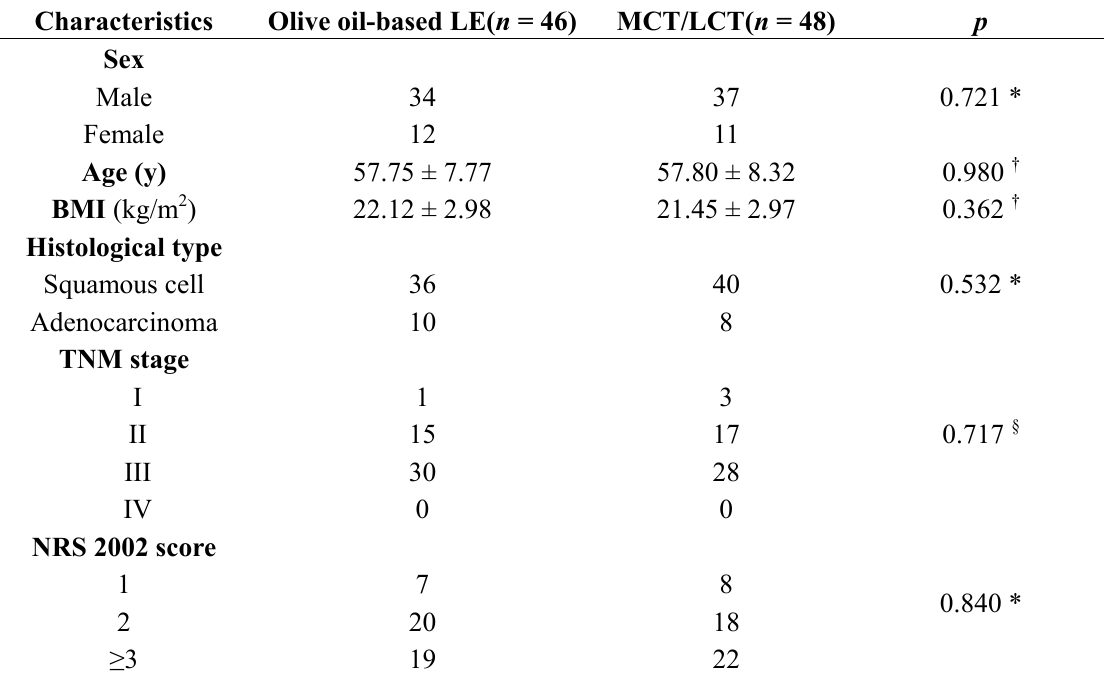
Table 2. Basic clinical characteristics in the two